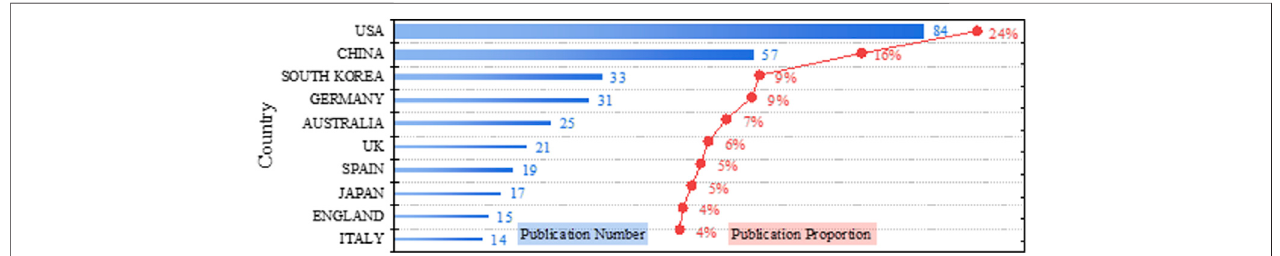
FIGURE 3 | Number of AR studies in civil infrastructure in different countries/regions.